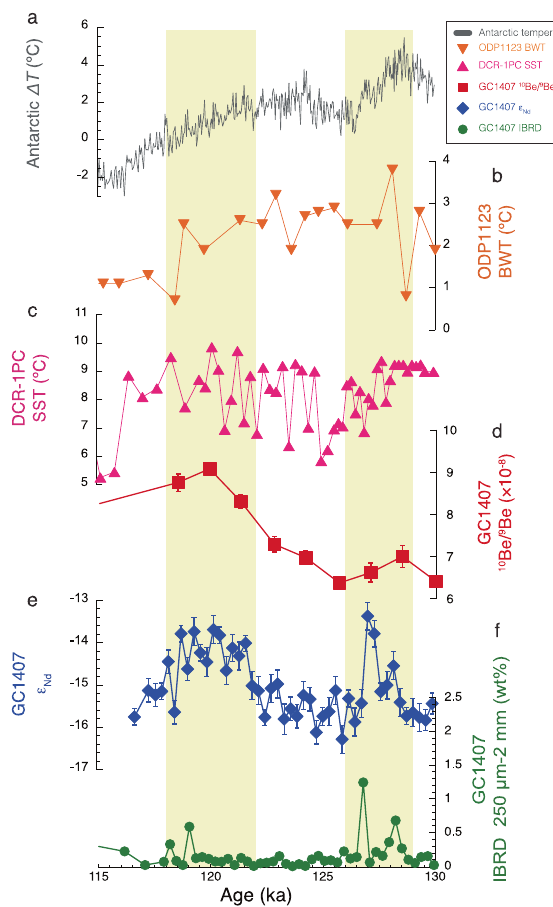
Fig. 3 | Comparison ofcore GC1407 records to regional palaeoclimate records. a Antarctic ice-core temperature difference ( Δ T, difference from mean values of the last millennium) derived from deuterium isotopes at EPICA Dome C (EDC) 39 plotted on the AICC2012 age scale (grey line). b Southern Ocean bottom water temperature (BWT) from benthic foraminiferal Mg/Ca ratios at Ocean Drilling Program (ODP) Site 1123 (orange triangles) 49 . c Southern Ocean sea surface temperature (SST) from diatom assemblages in core DCR-1PC (pink triangles) 50 . d Authigenic 10 Be/ 9 Be ratios from core GC1407 (red squares, this study) (error bars are 1s.d.). e Detrital sediment Nd isotopes ( ε Nd ) from core GC1407 (dark blue diamonds, this study) (error bars are 2s.d.). f Iceberg rafted debris (IBRD, percent 250 µ m – 2mm) from core GC1407 (green circles, thisstudy).Yellowbars indicate two episodes of inferred Wilkes Subglacial Basin ice mass loss during the early and late Last